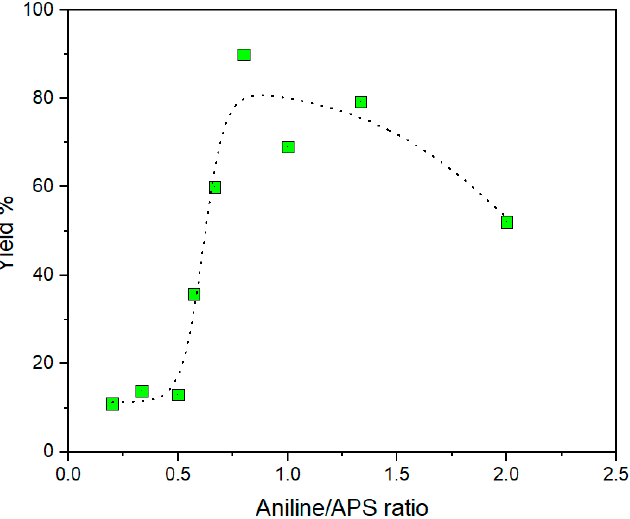
Figure 3. Effect of aniline/APS ratio on the yield% of PANI. (Recalculated using stoichiometry (Scheme 4) from data in [66]).